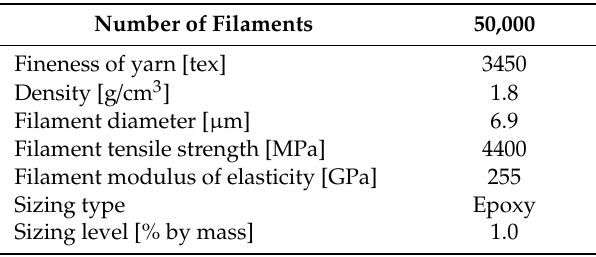
Table 1. Technical data of carbon yarn.